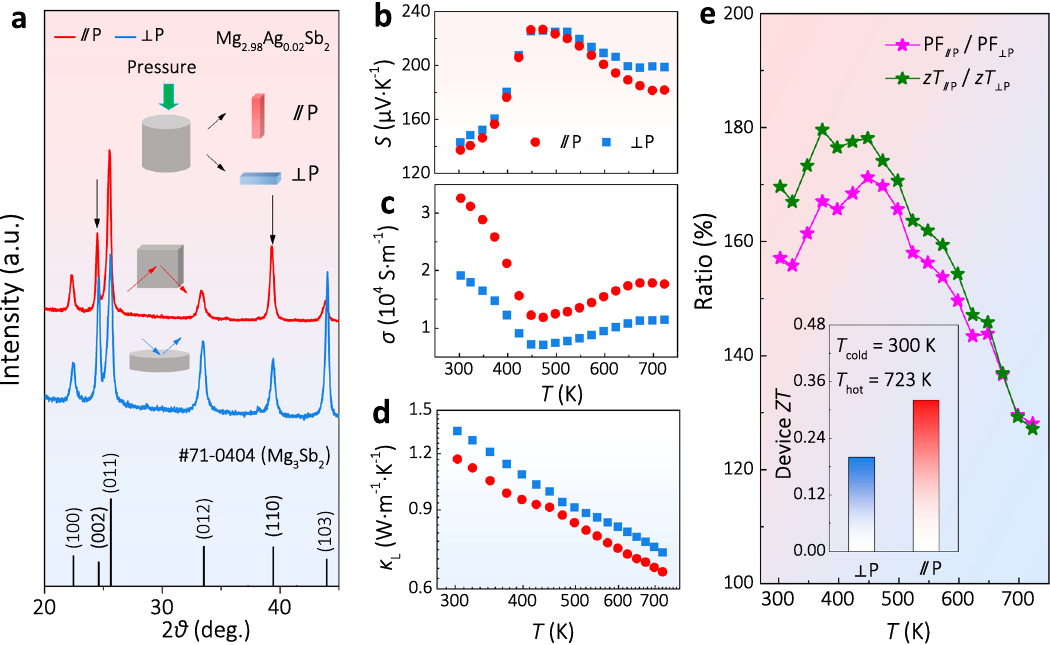
Fig. 5 The structure and TE properties of textured polycrystalline Mg 3 Sb 2 . a XRD patterns, temperature dependences of b S , c σ , d κ L , e zT , and PF ratios for the textured polycrystalline Mg 3 Sb 2 samples. The inset in e shows the calculated device ZT 36 .